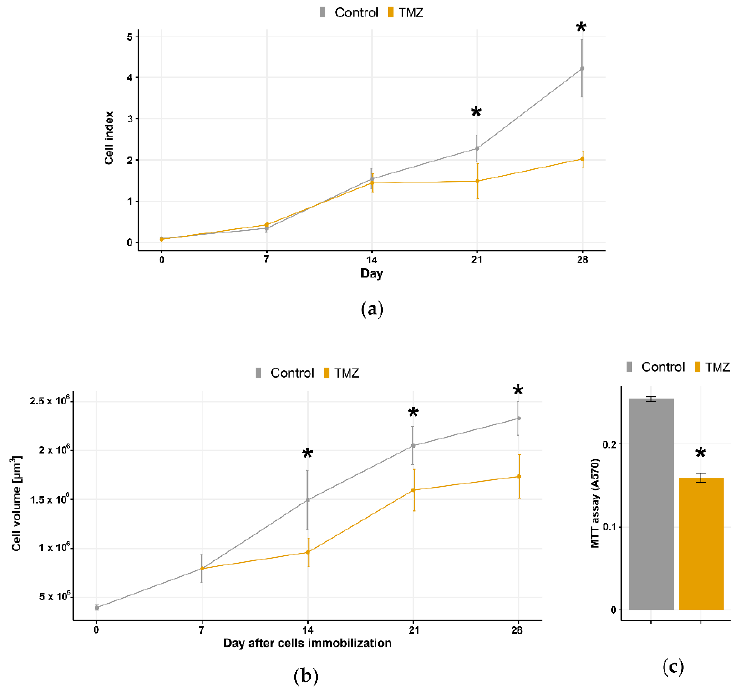
Figure 4. Anti-proliferative effect of TMZ treatments in 2D and 3D long-term cell cultures. Continuous monitoring of U87 glioblastoma cells after the TMZ ( a ) was assessed by xCELLigence real-time cell counter, which enables label-free real-time cell growth follow-up by measuring impedance-based signals expressed as Cell Index across a series of gold electrodes. ( b ) Effects of TMZ treatment on U87 cells in long-term 3D cell culture were assessed by LIVE/DEAD assay, and ImageJ software was used to calculate the Cell volume [ µ m 3 ] in alginate microfibers as an indirect measure of cell number. Viability of the U87 cells in long-term 3D cell culture after the TMZ treatments was assessed by the MTT assay. ( c ) The absorbance at the wavelength 570 nm is presented. All values are expressed as mean ± SD ( n ≥ 3). * indicates p < 0.05 statistical difference compared to the corresponding control cells.